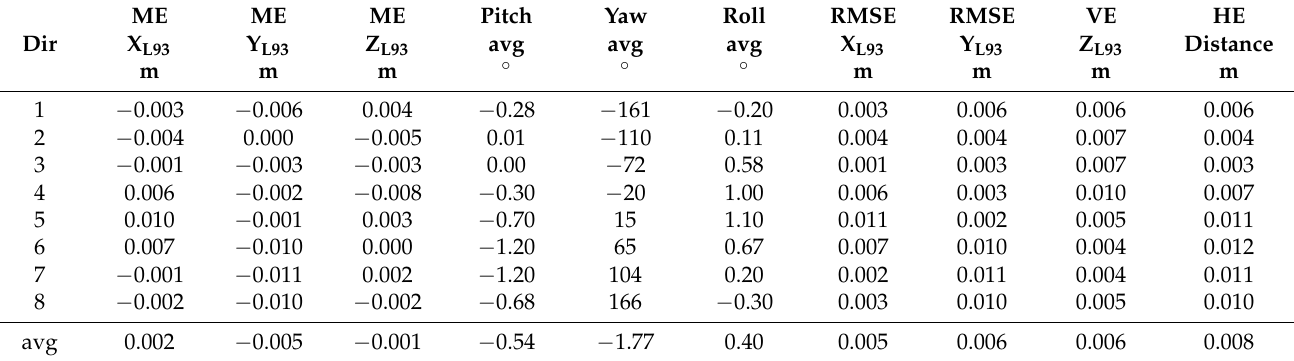
Table 6. Mean error (ME), root mean square error (RMSE), vertical error (VE) and horizontal error (HE) of GCP positions obtained using the P4-RTK antenna and the D-RTK2 station on the ground. Each line presents the average of 10 repetitions for one of the eight orientations of the drone; the last line presents the overall averages.